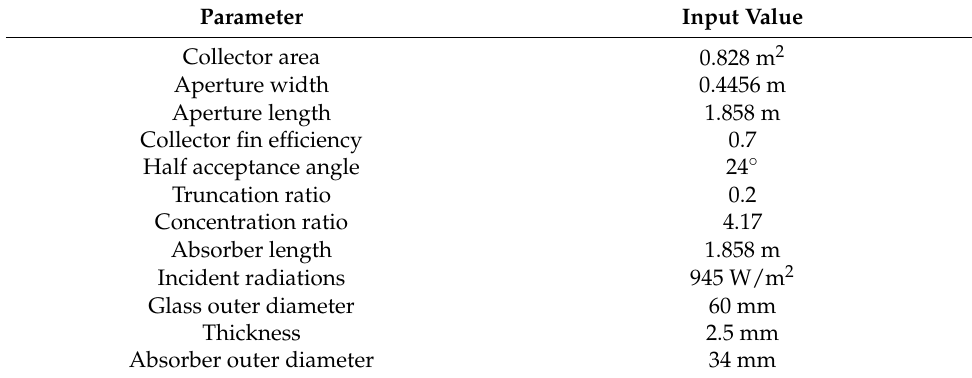
Figure 3. Experimental setup. Table 6. Solar system design parameters.